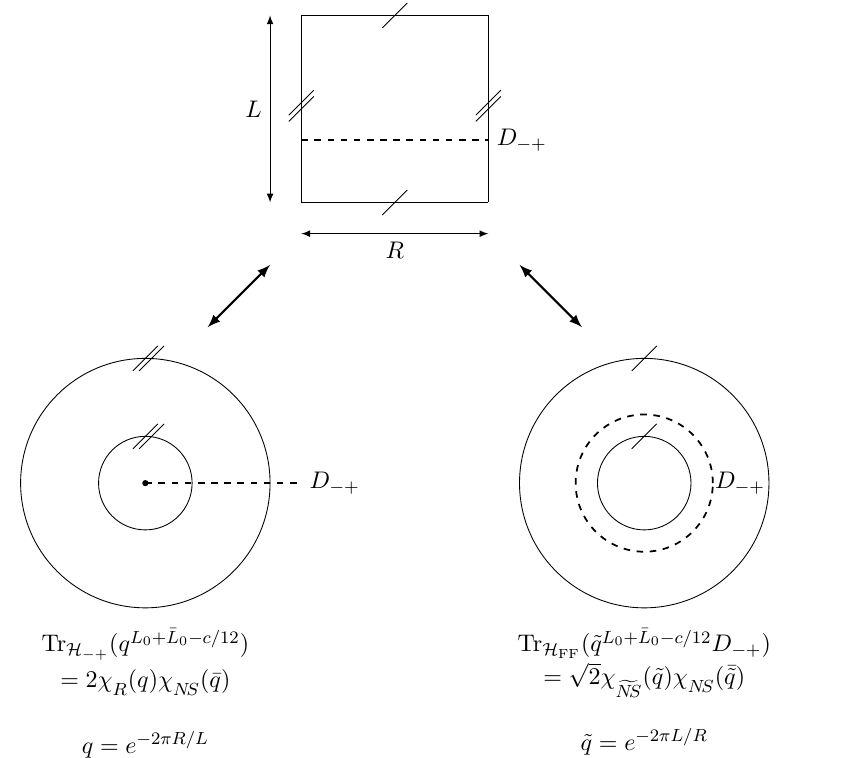
Figure 2 . The trace over the space of (cid:12)elds on which the D (cid:0) + defect can end is related by a modular transformation to the trace with the defect